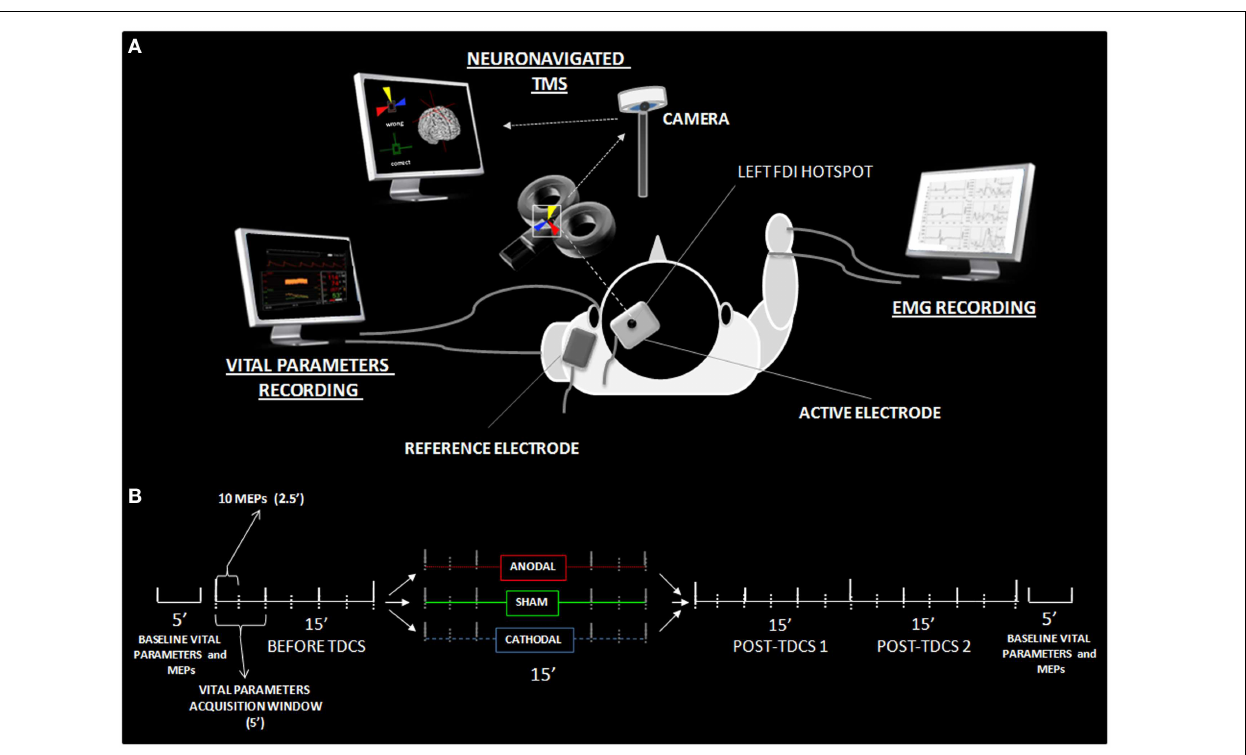
and vital parameters were acquired, respectively, every 2.5 and 5min. Analysis was performed on both high-resolution data and 15min collapsed windows (before, during, tDCS, post 1 and post 2). Additional vital parameter and MEP data were collected 5min before and after the experiment, in order to obtain basal-level values for data